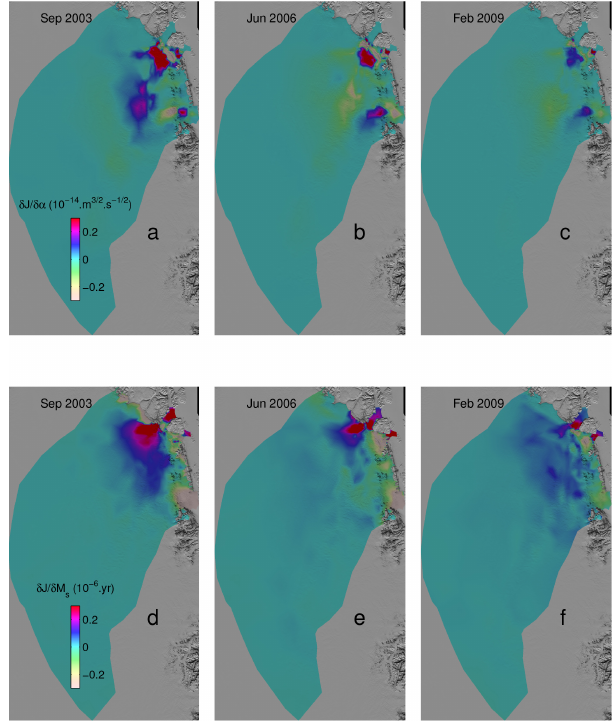
Figure 5. (a–c) Gradients ∂J/∂α (m 3 / 2 s − 1 / 2 ) of the cost func- tion J with respect to the ice–bed friction coefficient α in, respec- tively, September 2003, June 2006 and February 2009. (d–f) Gradi- ents ∂J/∂M s (yr) of the cost function J with respect to the surface mass balance M s in, respectively, September 2003, June 2006 and February 2009.